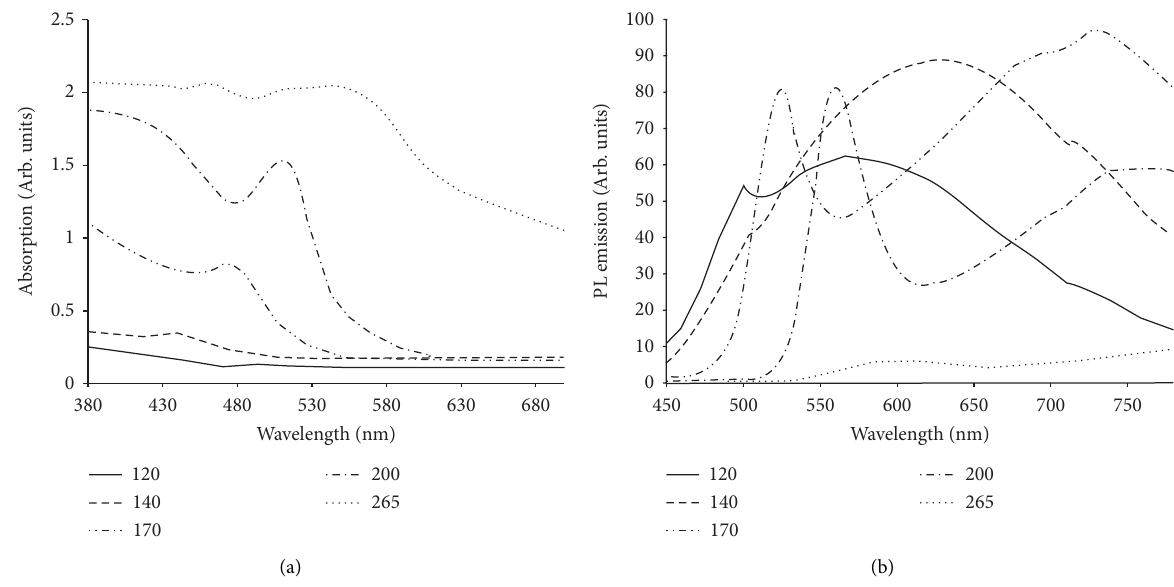
Figure 2: Comparison of UV-vis absorption (a) and PL emission ( λ